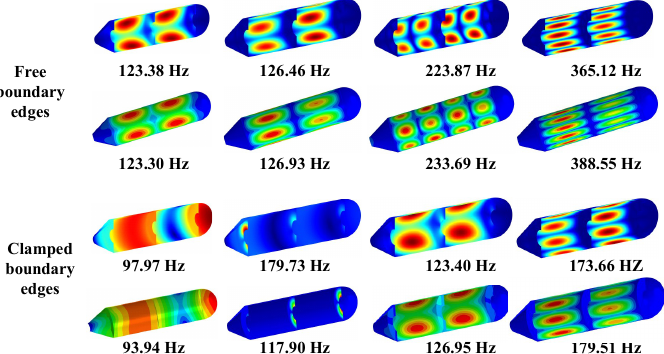
Figure 5. Comparison of modal shapes and corresponding frequencies obtained by the two meth- ods.